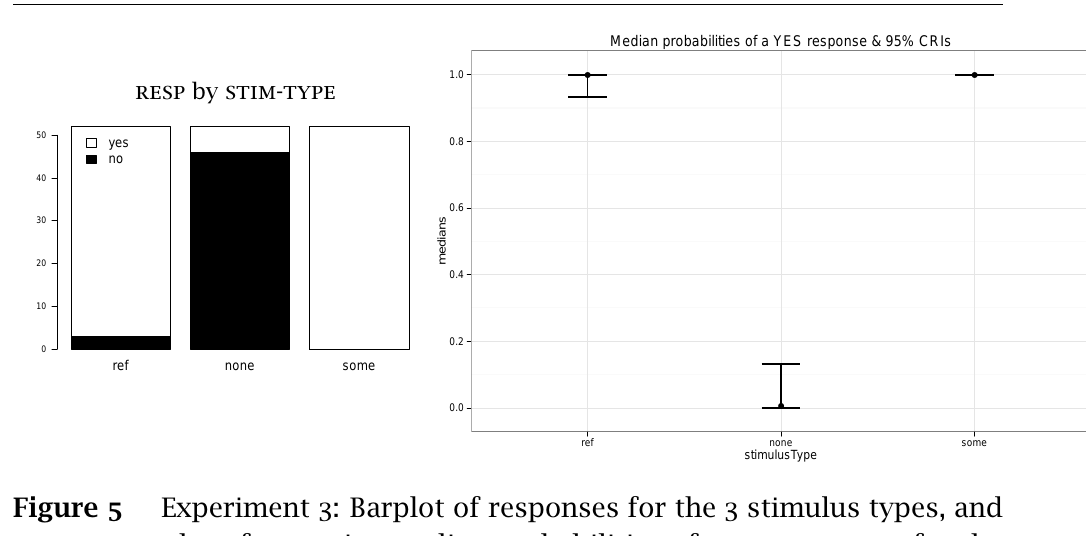
Figure 5 Experiment 3 : Barplot of responses for the 3 stimulus types, and plot of posterior median probabilities of a yes response for the same 3 stimulus types and corresponding 95 %